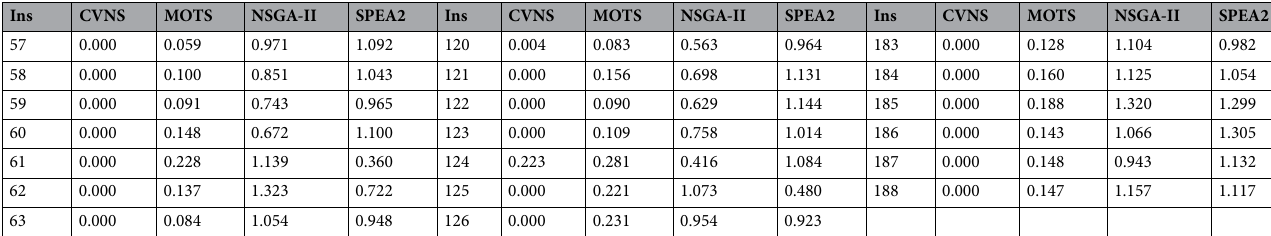
Table 5. Computational results of four algorithms on metric IGD .